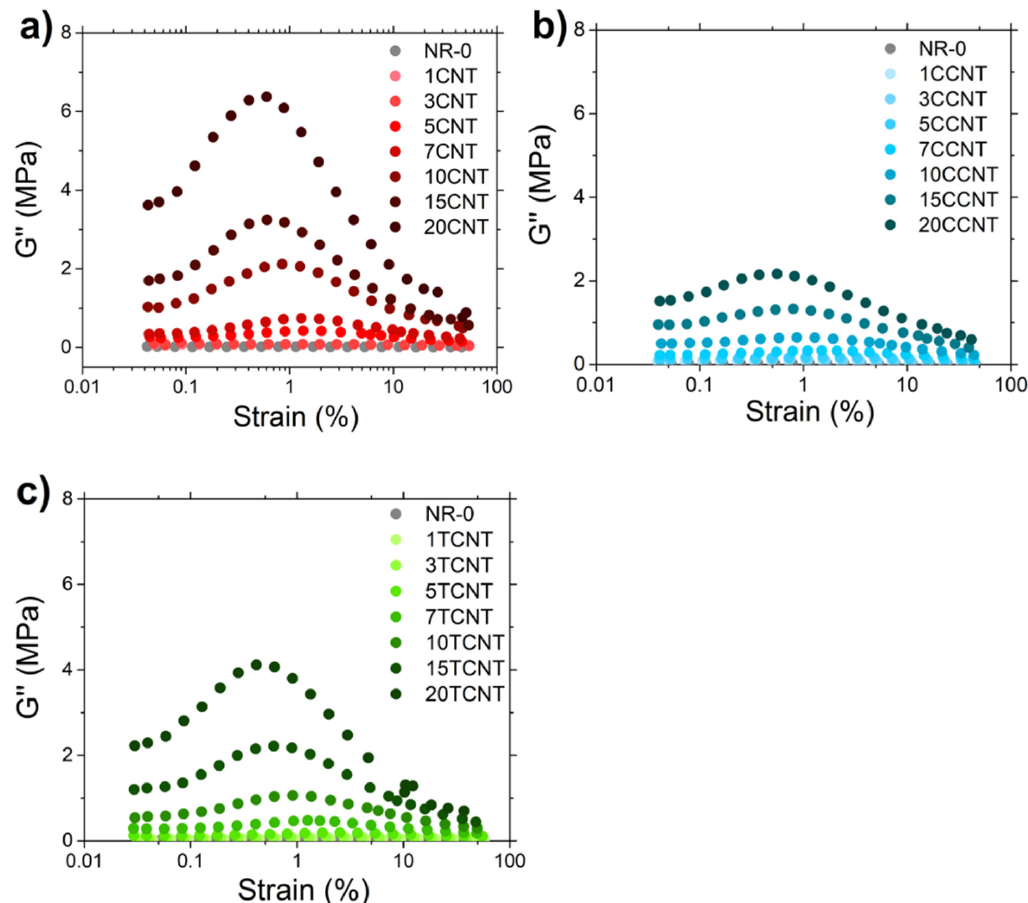
Figure 15. Strain dependence of G'' for the CNT filled samples ( a – c ).